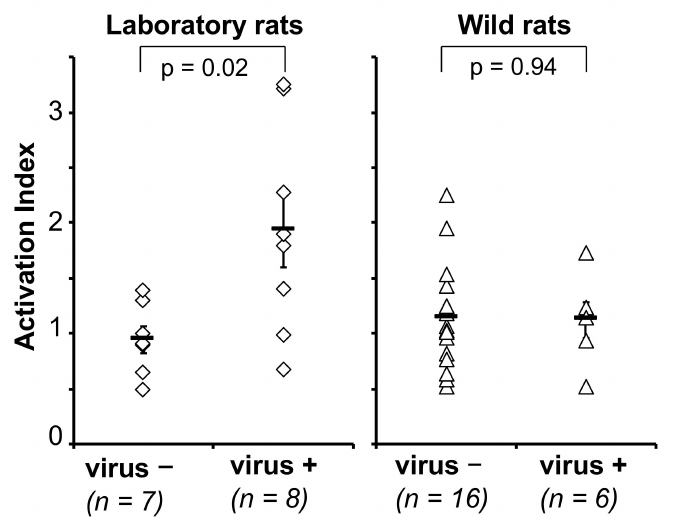
Figure 4. Detection of cytotoxic T lymphocyte activities in laboratory rats experimentally inoculated with SEOV, and wild rats naturally infected with